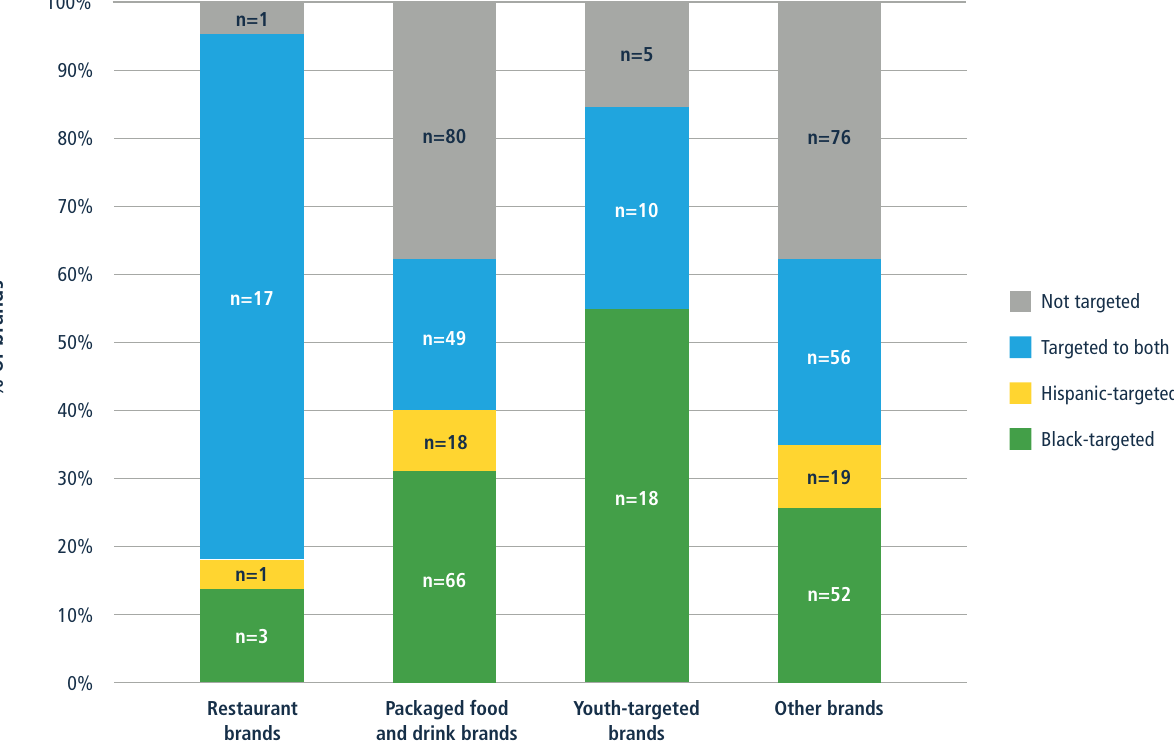
FIGURE 12. PROPORTION OF HIGHLY ADVERTISED BRANDS TARGETED TO BLACK AND/OR HISPANIC